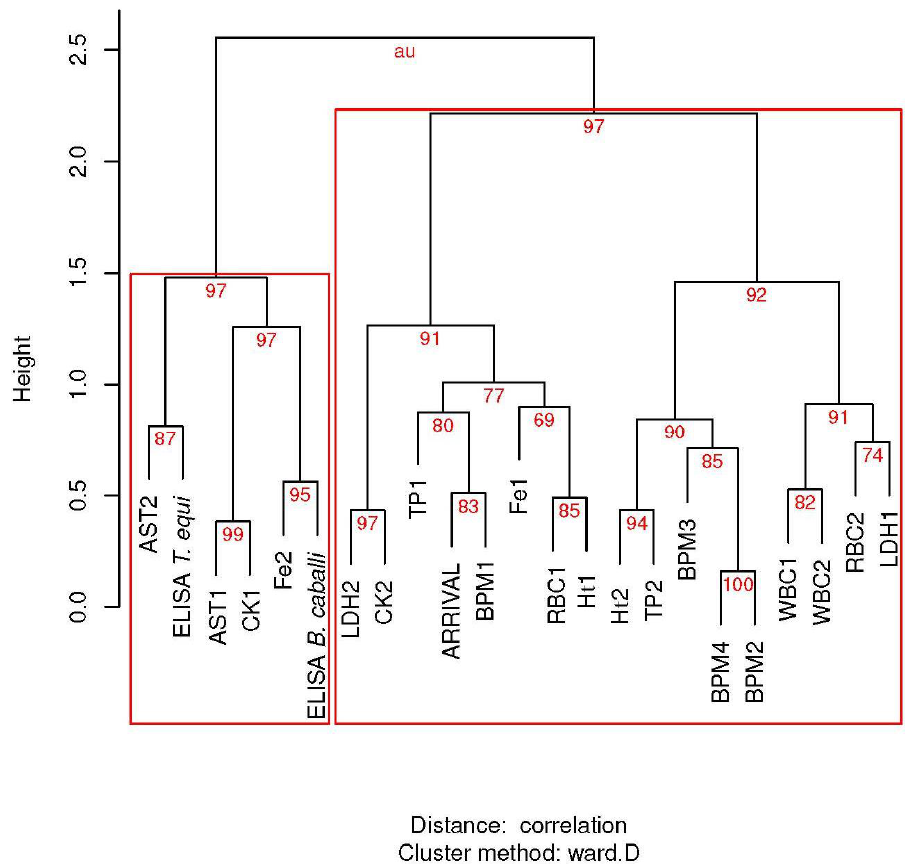
Figure 2. Hierarchical clustering via multiscale bootstrap resampling (n = 10,000) of arrival position in endurance horses with hematological and biochemical variables before and after the race, and with BPM controls (BPM1 to BPM4) during the competition. Repeated measures are indicated by the number of suffixes. Red numbers are the percentage of the signification of each cluster based on approximately unbiased p -values (au). Red rectangles show major significant clusters. AST: aspartate aminotransferase; CK: creatinine kinase; Fe: Iron; Ht: hematocrit value; LDH: lactate dehydrogenase; RBC: red blood cells; TP: total proteins; WBC: white blood cells. The evolution of BPM in seronegative and seropositive horses was also similar. The